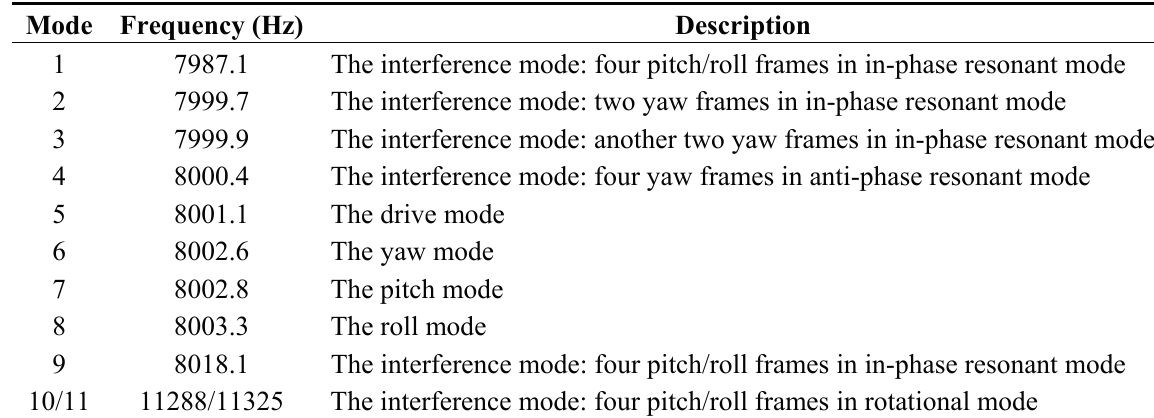
Table 8. Summary of the modal simulation